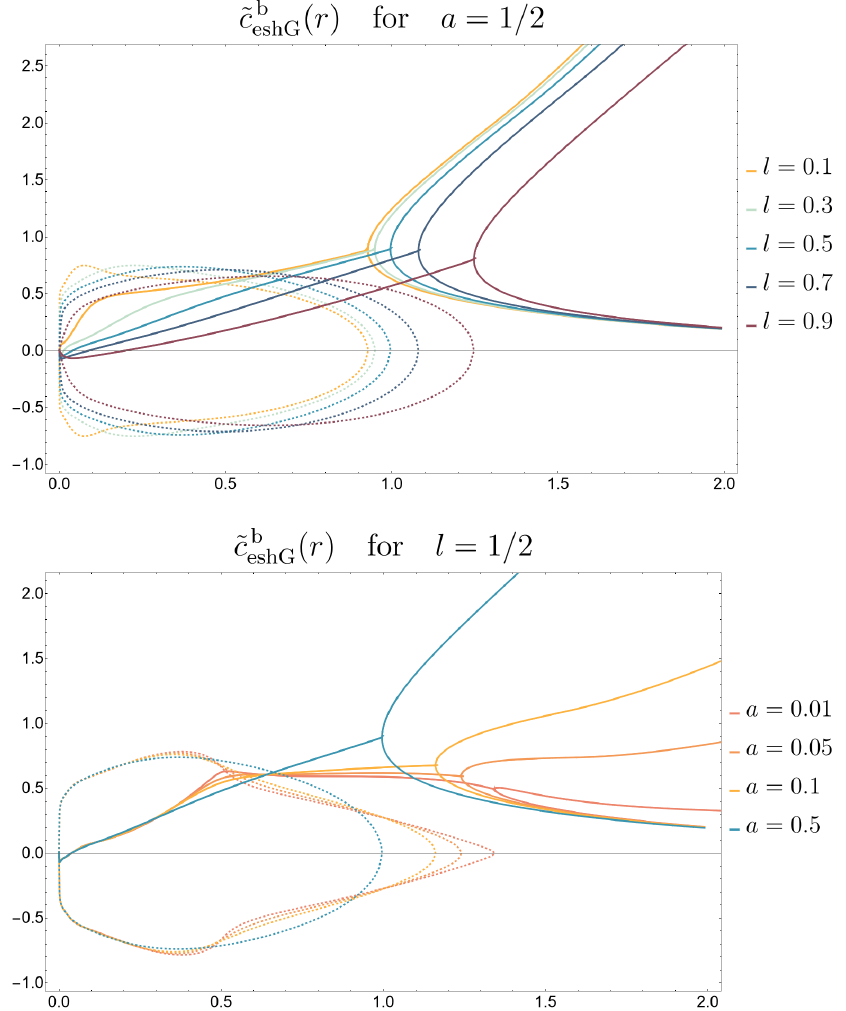
Figure 6. Effective central charge for the bosonic elliptic sinh-Gordon model. Plots for various values of l with fixed a = 1 / 2 (top), and various values of a with fixed l = 1 / 2 (bottom). Above a critical radius r c there are two branches of real solutions, whereas below this radius there is a pair of complex-conjugate solutions with non-vanishing imaginary parts (dashed lines). The effective central charge in the ultraviolet ˜ c ( r = 0) = 0 can be computed from the plateau solutions as explained in the main text. Numerical solutions were computed using the pseudo-arclength continuation method described in section 3 with N = 200 and M = 2